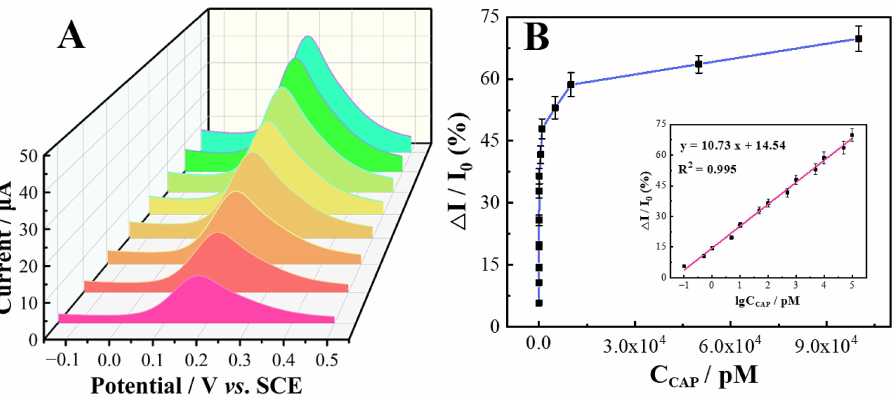
Figure 5. ( A ) DPVs of the aptasensor in different concentration of CAP in 5 mM [Fe(CN) 6 ] 3 − /4 − (1:1) containing 0.1 M KCl (from 0.1, 1, 10, 100, 1 × 10 3 , 1 × 10 4 , 1 × 10 5 pM). ( B ) Dependence of inhibition ratio on the concentration of CAP. Insert shows the linger curve of ∆ I/I 0 vs.